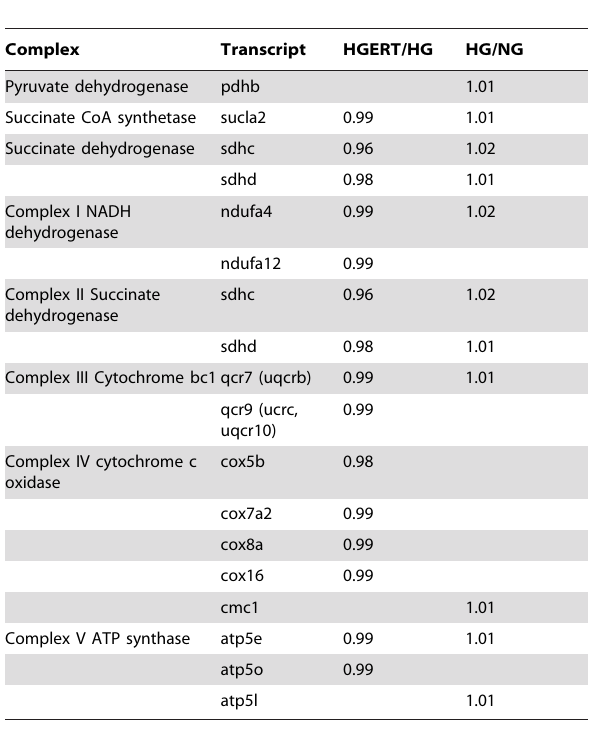
Table 4. Transcripts changed in citric acid cycle and electron transport